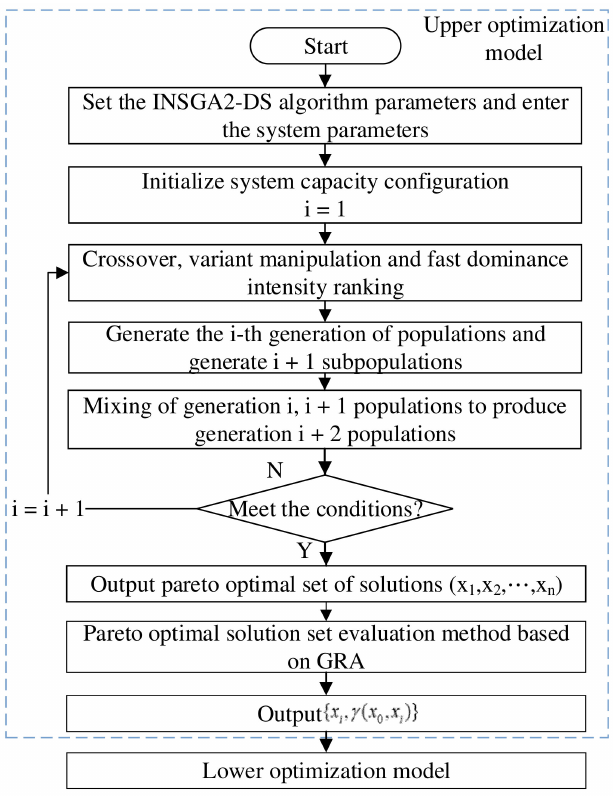
Figure 4. Flow chart of the upper optimization model